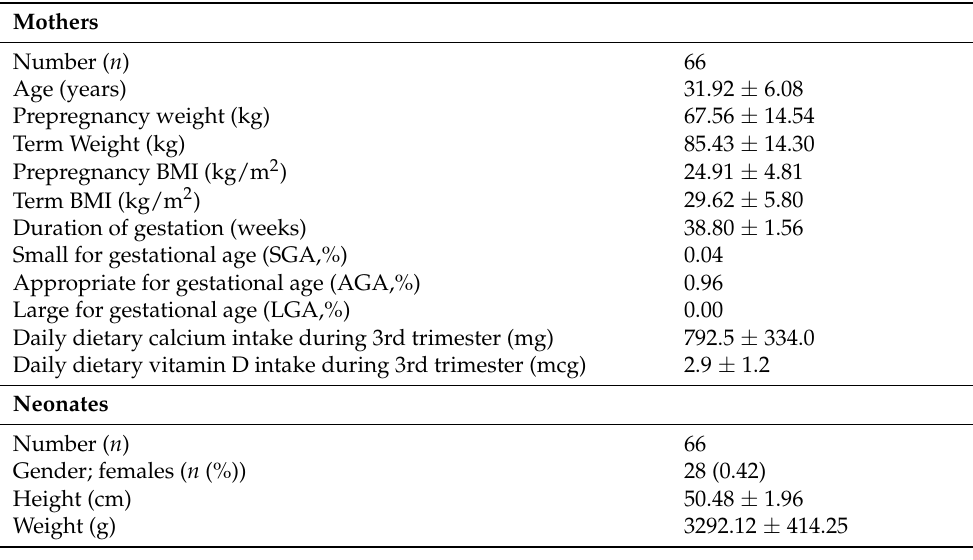
Table 1. Demographics of mothers and neonates.